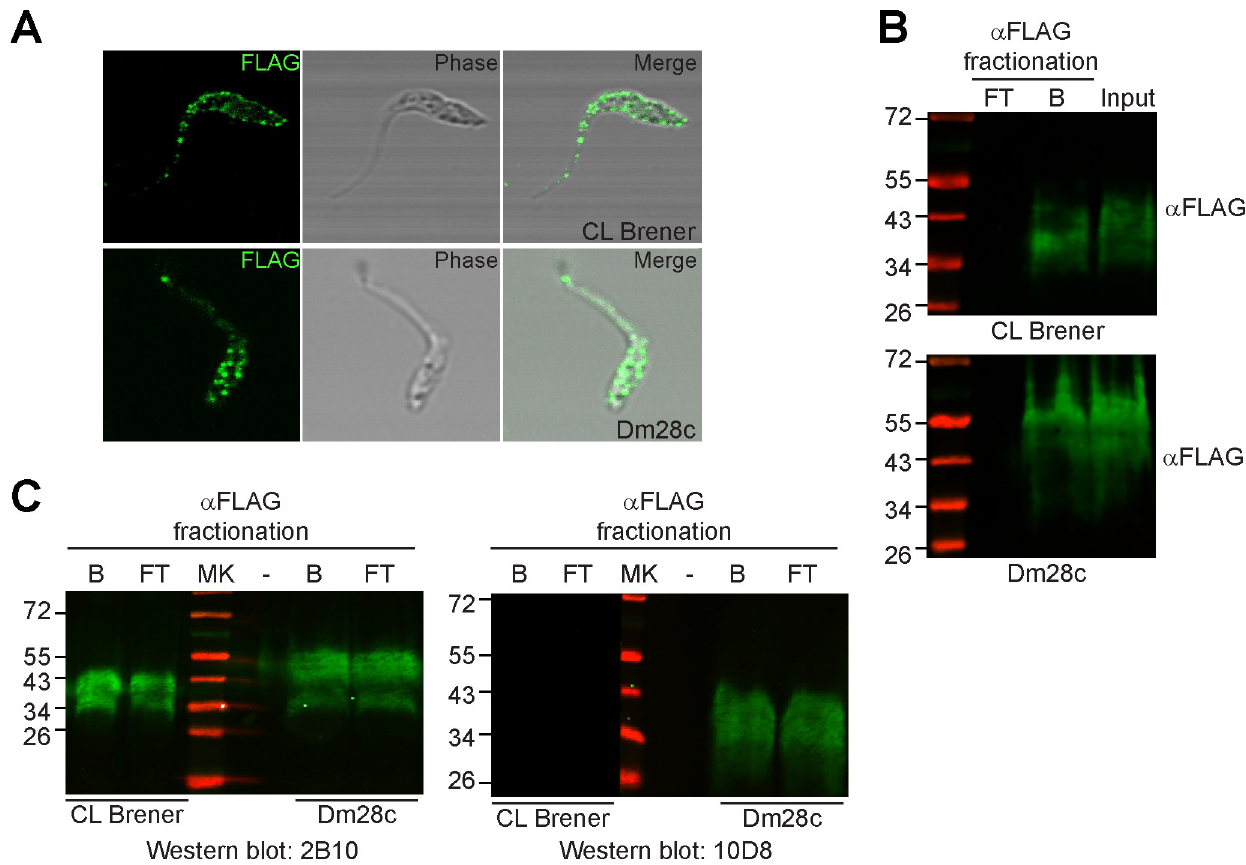
Fig 1. Homologous expression and characterization of recombinant Gp35/50 kDa mucins. A) Indirect immunofluorescence assays of permeabilized epimastigotes over-expressing TcSMUG S (TcSMUG S ox) from the indicated parasite clone revealed with mAb anti-FLAG. B) Lysates from TcSMUG S ox epimastigotes from the indicated parasite clone were fractionated on to anti-FLAG-Sepharose and input, flow-through (FT) and bound (B) fractions were probed with an anti-FLAG polyclonal antibody. C) Aliquots of the FT and B fractions were probed either with mAb 2B10 or mAb 10D8, recognizing Gal p- and Gal f- based glycotopes restricted to T . cruzi Gp35/50 kDa mucins, respectively. In B and C , the positions of relative molecular mass markers (in kDa) are